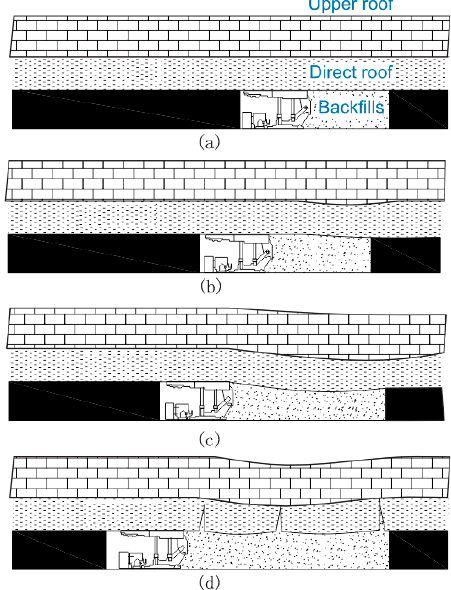
Figure 17. Strata movement with working face advancing. ( a ) Initial roof stable stage; ( b ) Overlying strata separation stage; ( c ) The first pressure appearance stage; ( d ) The overlying strata periodical pressure stage.